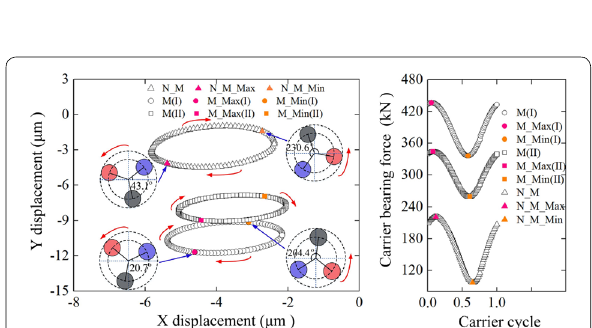
Figure 16 The vibration displacement and bearing force of carrier with three cases: without main shaft (N_M), one-point suspension of main shaft (M(I)) and two-point suspension of main shaft (M(II))